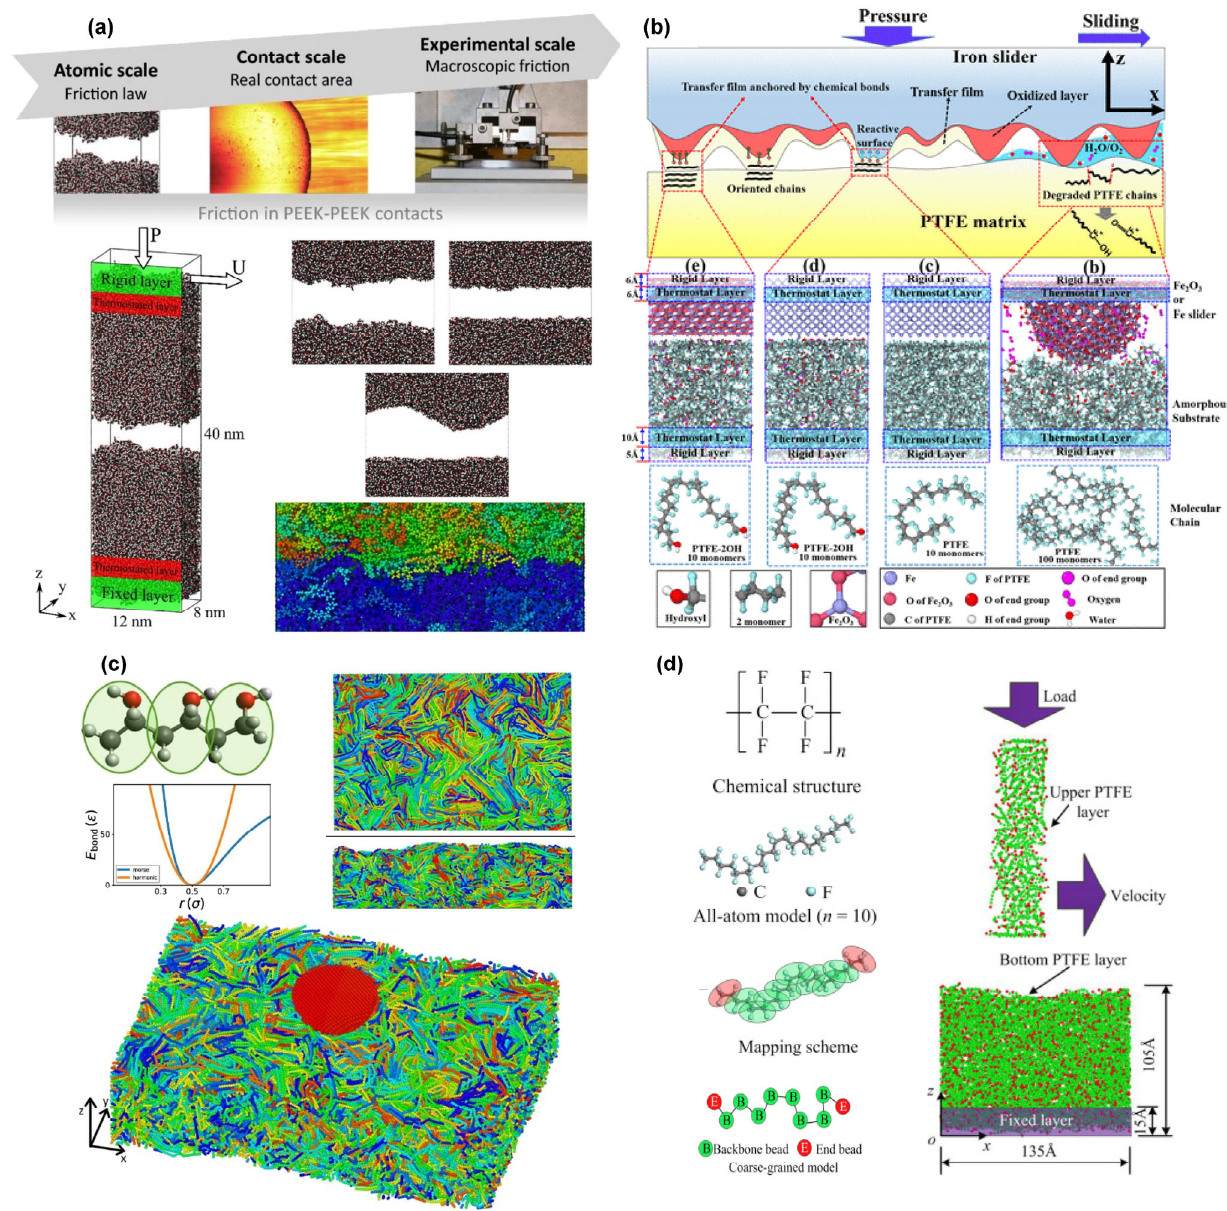
Fig. 80 Atomistic or coarse-grained molecular dynamics simulations of tribology of polymeric materials [941, 943, 948, 949]. Reproduced with permission from Ref. [941], © The Author(s), under exclusive licence to Springer Science+Business Media, LLC, part of Springer Nature, 2021; Reproduced with permission from Ref. [943], © American Chemical Society, 2022; Reproduced with permission from Ref. [948], © The author(s), 2021; Reproduced with permission from Ref. [949], © Elsevier Ltd.,